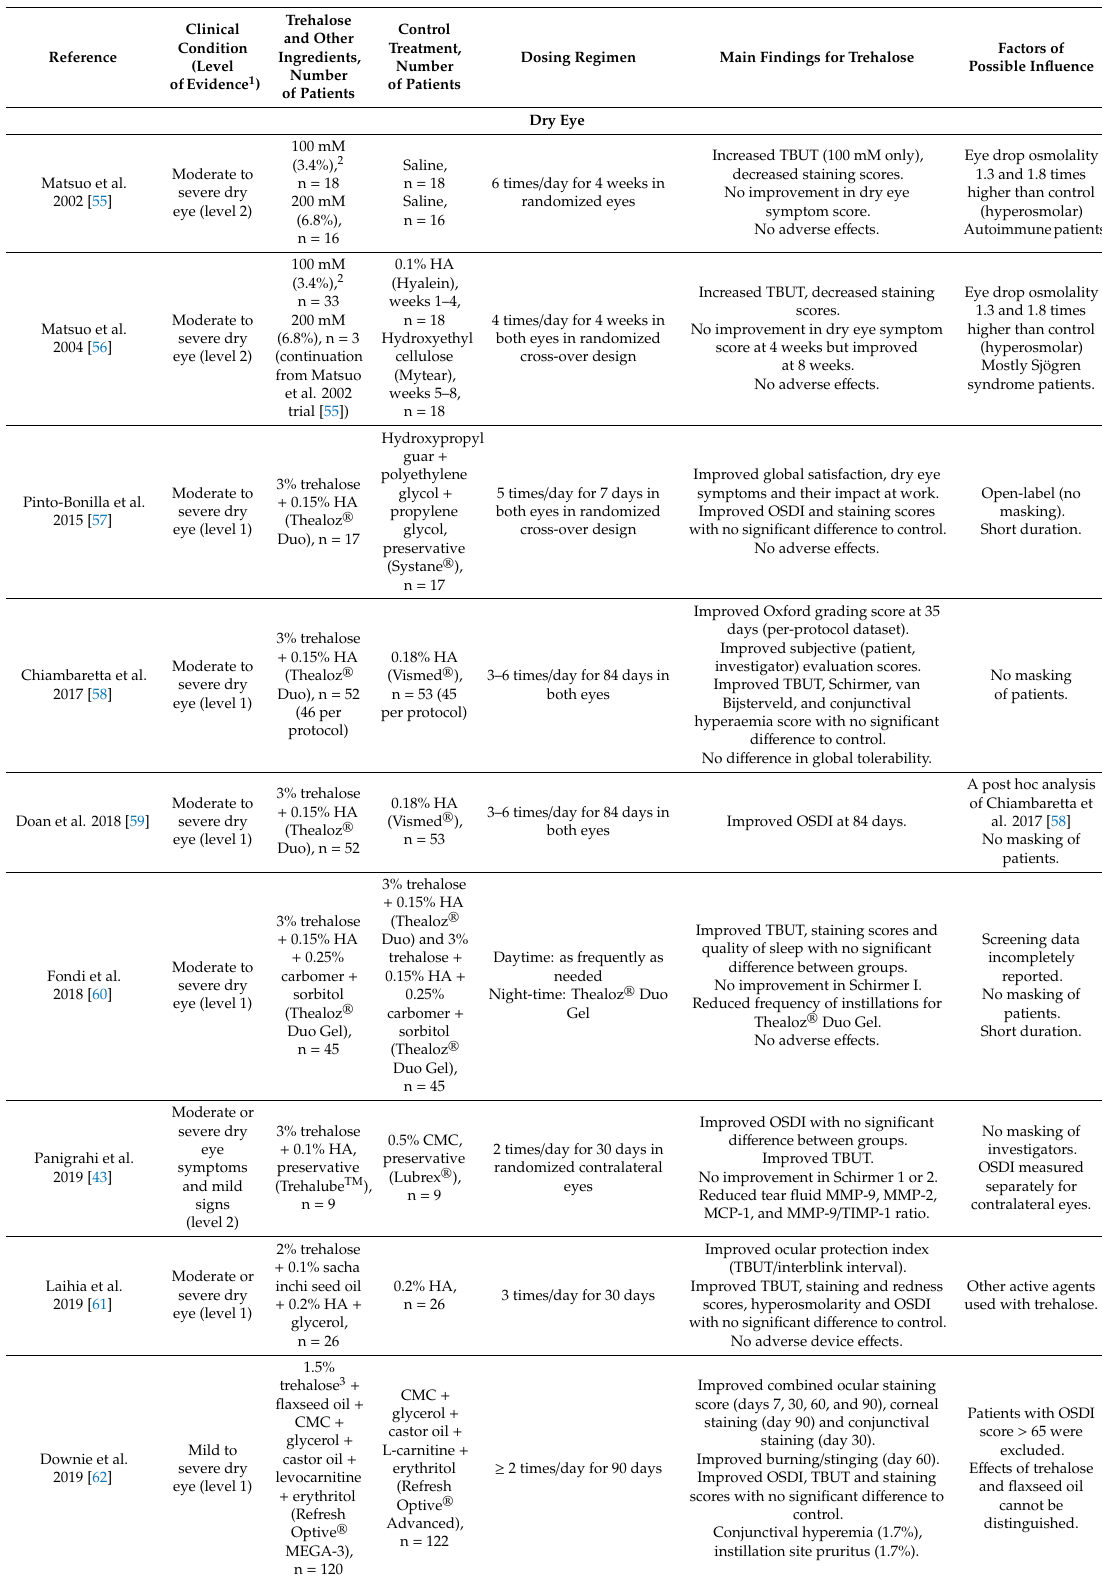
Table 1. Randomized controlled trials with trehalose treatment on ocular surface.